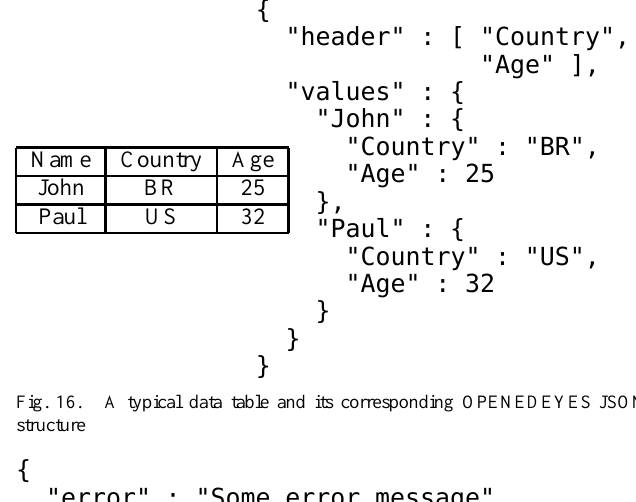
Fig. 16. A typical data table and its corresponding OPENEDEYES JSON structure { } Fig. 17. OPENEDEYES error